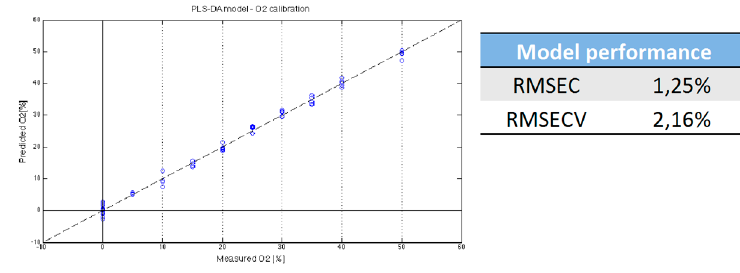
Figure 2. Data analysis results. Fingerprints obtained by different concentration of O 2 and CO 2 are processed by PLS-DA model. RMSEC and RMSECV are